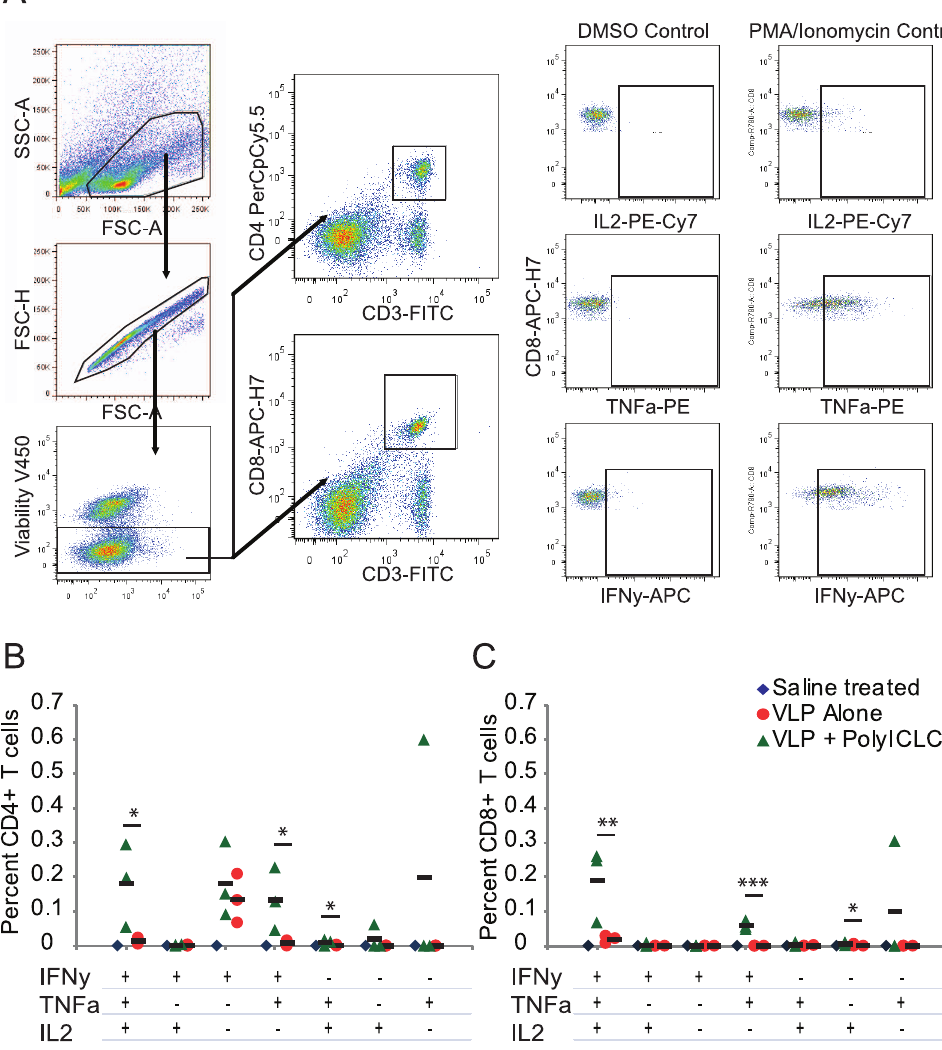
Figure 3. PolyICLC enhances antigen-specific T cell responses during VLP vaccination. C57BL/6 mice were vaccinated with 10 m g of VLP, with or without 1 m g of polyICLC. Vaccination was on the same schedule as in Figure 1, and control animals were vaccinated with saline or polyICLC alone. Four weeks after the vaccine boost, splenocytes were harvested and cells were re-stimulated with DMSO or Marburg peptides, PMA/ ionomycin, or a known EBOV peptide. IFN c , TNF a , and IL2 responses of viable CD4 and CD8 T cells were measured; gating was on lymphocytes, viable cells, and then CD3 + CD4 + or CD3 + CD8 + T cells (A). Percentages shown are the percent of the CD4 + (B) or CD8 + (C) T cell populations that were cytokine positive, after subtracting the background elicited by DMSO. P values were determined using the Student’s T-test by comparing the percentage of responding cells in animals vaccinated with VLP alone versus vaccination with VLP and polyICLC. ‘‘*’’ indicates p , 0.05, ‘‘**’’ indicates p , 0.005, and ‘‘***’’ indicates p , 0.0005. Four animals were utilized in each group for each iteration of this experiment, and the experiment was repeated two times.